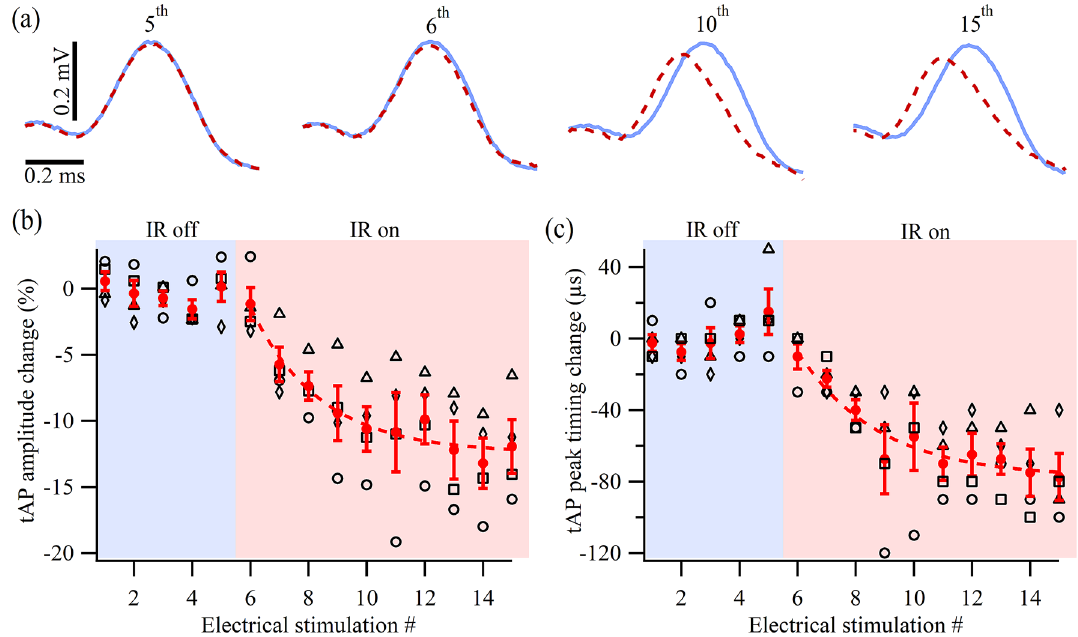
Figure 5. IR light effects on tAPs. ( a ) Representative examples of the tAPs, with (dashed red) and without (solid blue) IR light illumination, recorded immediately before (5th) and at various times (6th, 10th, 15th) after the onset of an IR light pulse. ( b ) Percentage changes in tAP amplitude before and during an IR light pulse ( N = 4). ( c ) Changes in the tAP peak timing before and during an IR light pulse ( N = 4). Each type of the black symbols in ( b ) and ( c ) represents a set of data recorded from one animal. Each solid red dot and bar represent the average ± SEM. The dashed red lines in ( b ) and ( c ) are exponential fits to the measured data.